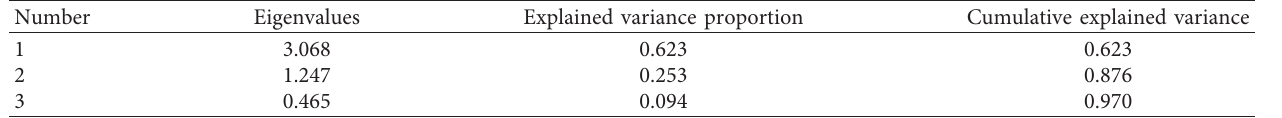
Table 1: Eigenvalues and variance for